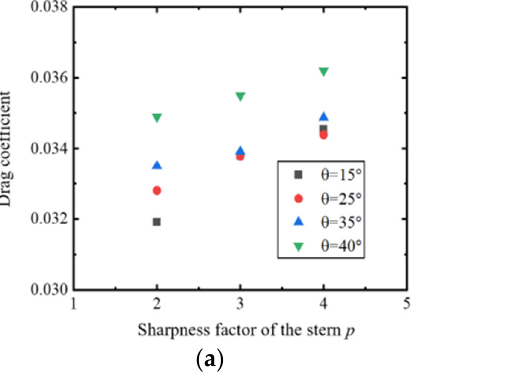
Figure 8. Drag coe ffi cient of di ff erent hull models in terms of straight-line motion ( a ) and oblique Figure 8. Drag coefficient of different hull models in terms of straight-line motion ( a ) and oblique motion ( b ) with di ff erent angles of a tt ack. motion ( b ) with different angles of